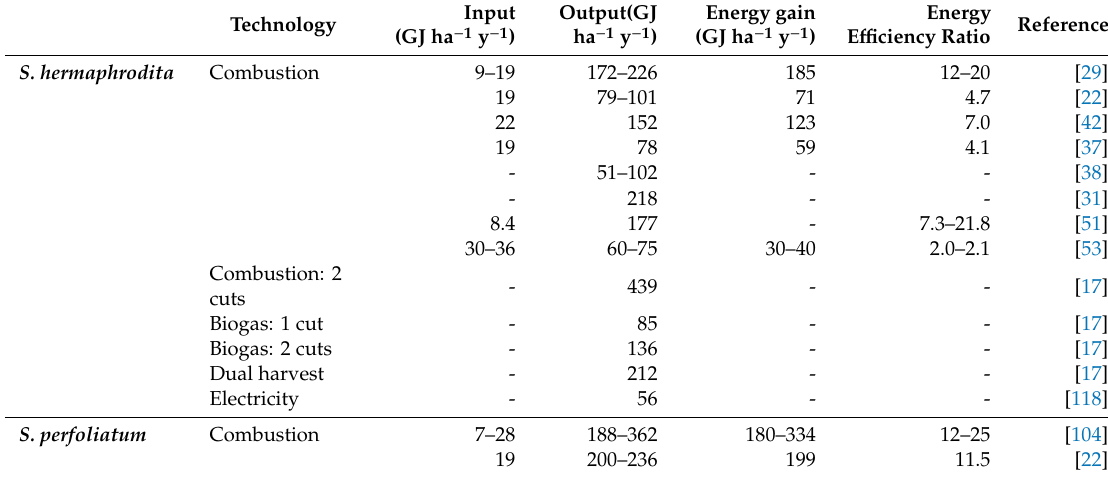
Table 11. Reported energy requirements and energy outputs, and corresponding energy balances for S. hermaphrodita and S. perfoliatum